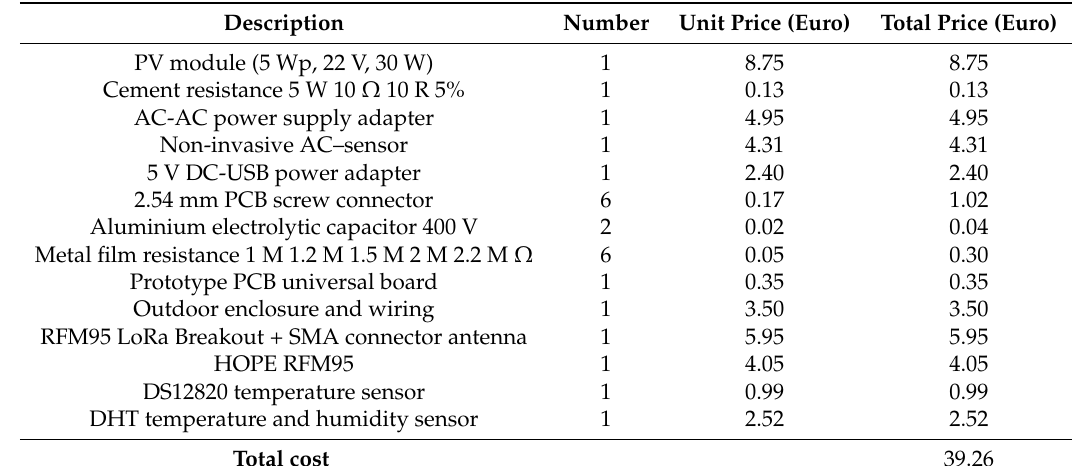
Table 1. PV monitoring node